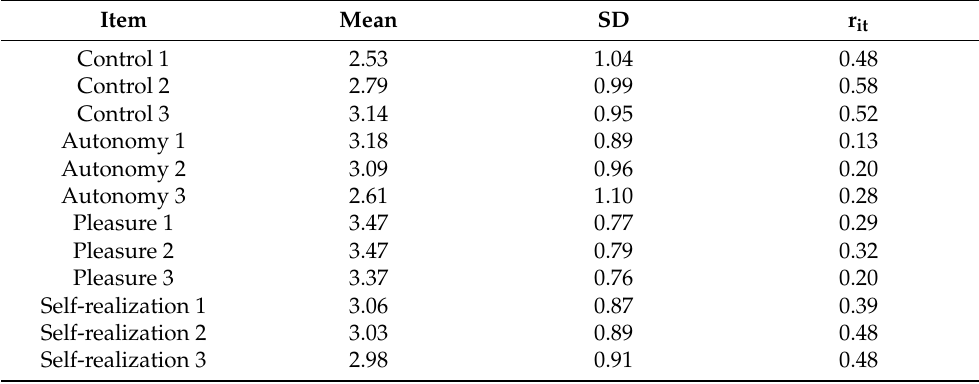
Table 2. Means, standard deviations (SD), and corrected item-total correlations ( r it ) for the 12 items in the CASP measure (Control, Autonomy, Self-realization and Pleasure).